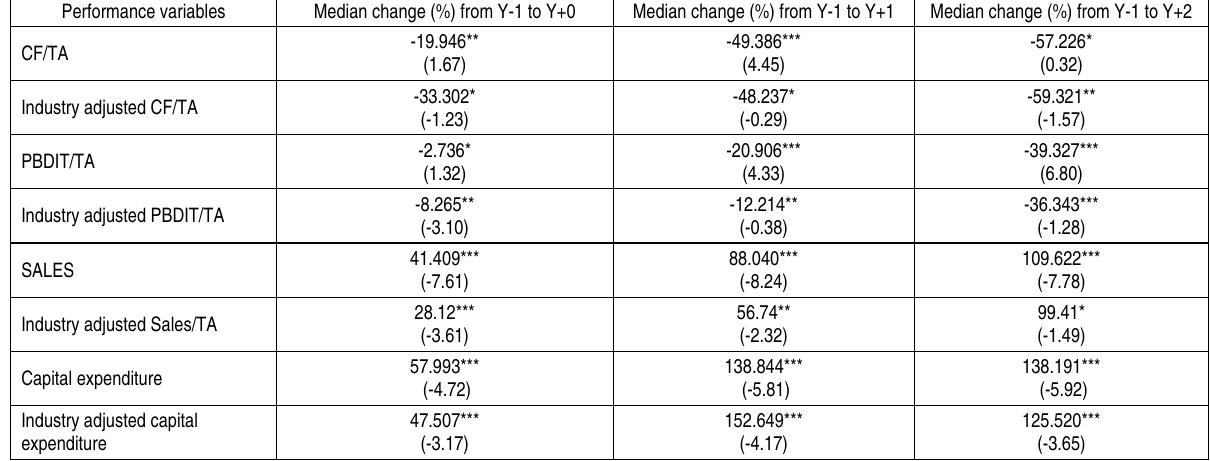
Table 5. Median changes in performance variables of Indian public firms around their